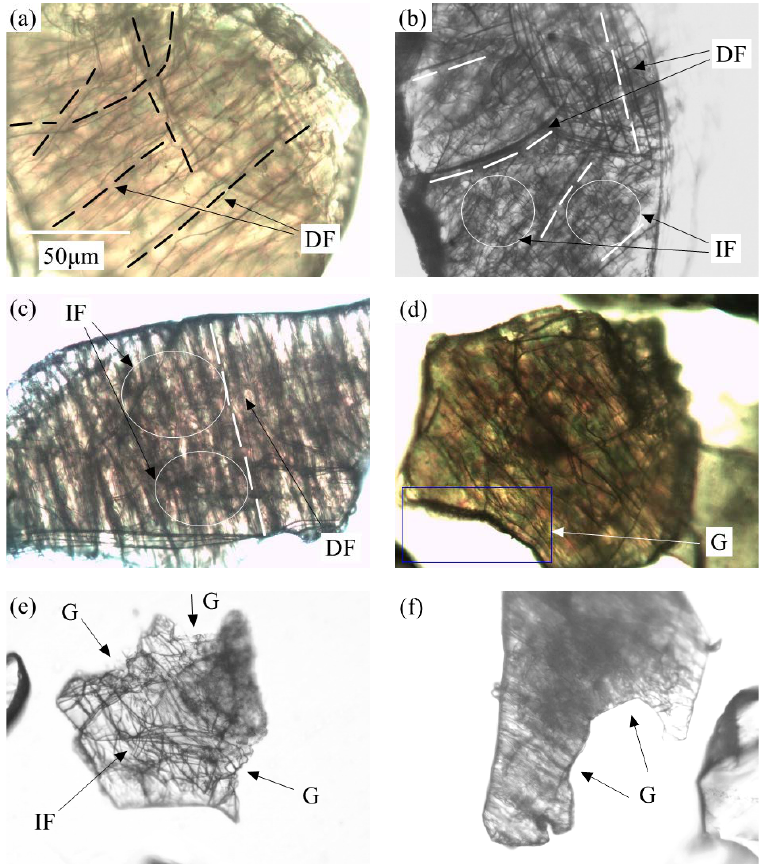
Figure 2. Optical morphology of muscovite within leached quartz sand: (1) 0.025 mol/L H 2 SO 4 , 0.050 mol/L NH 4 Cl ( a ) − 150 ◦ C; ( b ) − 200 ◦ C; ( c ) − 250 ◦ C; (2) 0.050 mol/L H 2 SO 4 , 0.100 mol/L NH 4 Cl ( d ) − 150 ◦ C; ( e ) − 200 ◦ C; and ( f ) − 250 ◦ C; DF—directional fracture, IF—interlaced fracture. G—“gulf”; the scale bars are the